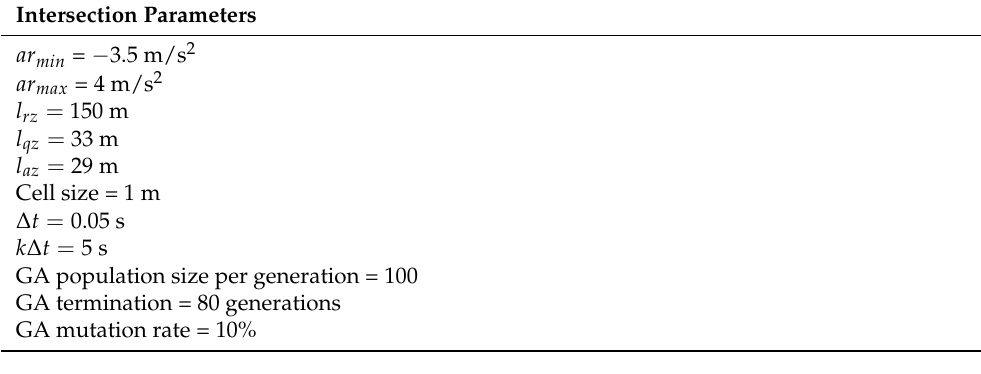
Table 5. Parameters used in our proposed system.